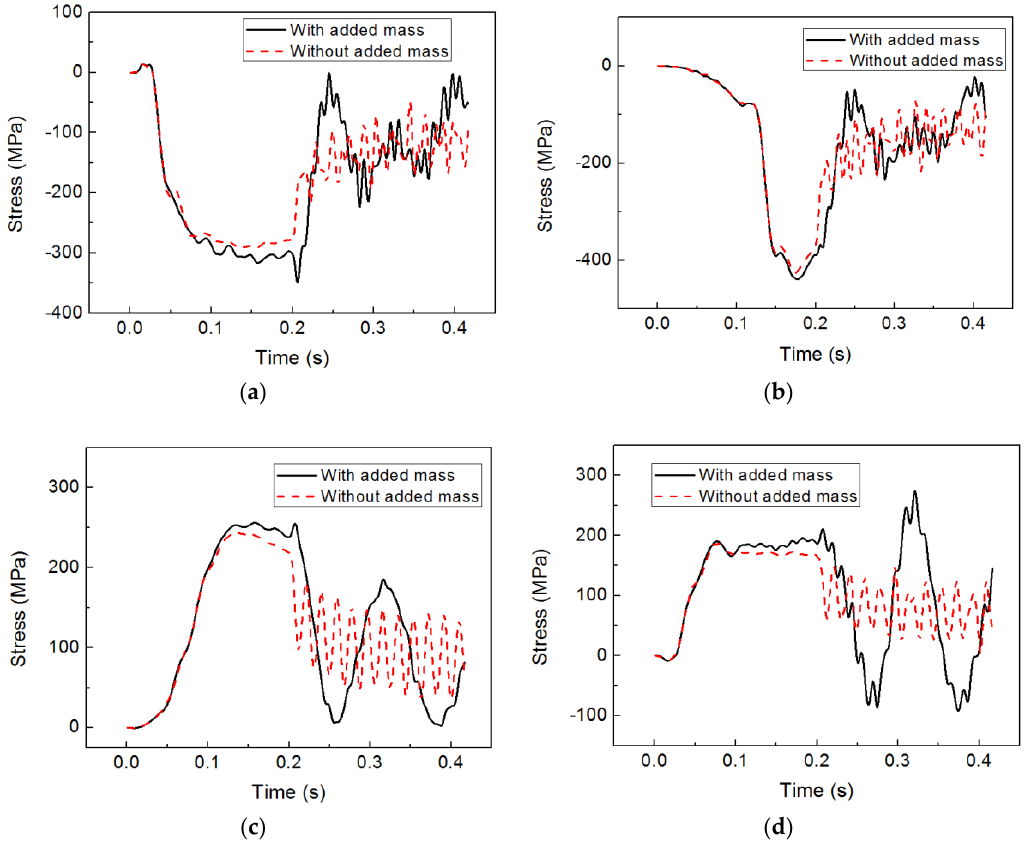
Figure 9. Comparative analysis on the effect of the added mass. ( a ) S1; ( b ) S3; ( c ) S5; ( d ) S7. Table 2. Comparison of peak values of absolute stresses.